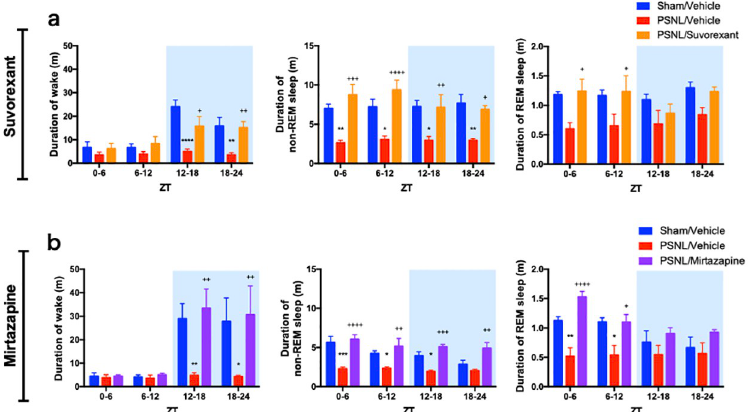
Fig 4. Influence of daily administration of suvorexant or mirtazapine on the duration of arousal and sleep in PSNL. The mean durations of wakefulness, non-REM sleep, and REM sleep in both suvorexant (a) and mirtazapine (b) experiments, were calculated every 6 h. Data are expressed as means ± SEMs (sham-vehicle, n = 5–6; PSNL-vehicle, n = 5; PSNL-suvorexant, n = 6; PSNL-mirtazapine, n = 5). � P < 0.05, �� P < 0.01, ��� P < 0.001, and ���� P < 0.0001 compared between each sham-vehicle and PSNL-vehicle group, and + P < 0.05, ++ P < 0.01, +++ P < 0.001, and +++ + P < 0.0001 compared between each PSNL-vehicle and PSNL-drug (suvorexant or mirtazapine) group by two-way ANOVA with Bonferroni post-test. Abbreviations: ANOVA, analysis of variance; PSNL, partial sciatic nerve ligation; REM, rapid eye movement; SEM, standard error of the mean; ZT, Zeitgeber